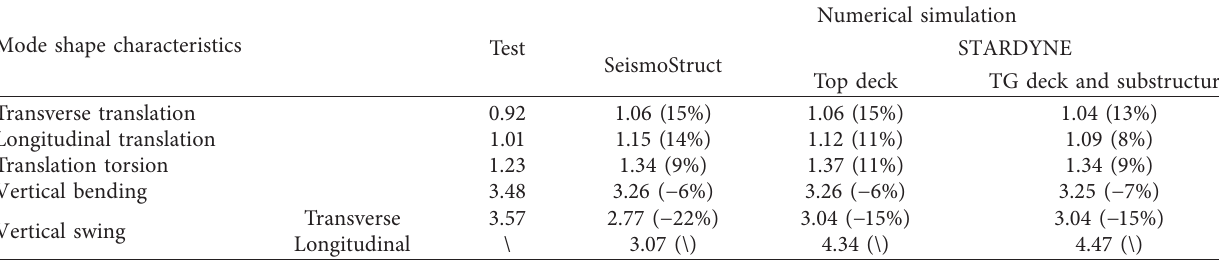
Table 5: Contrast of natural frequencies